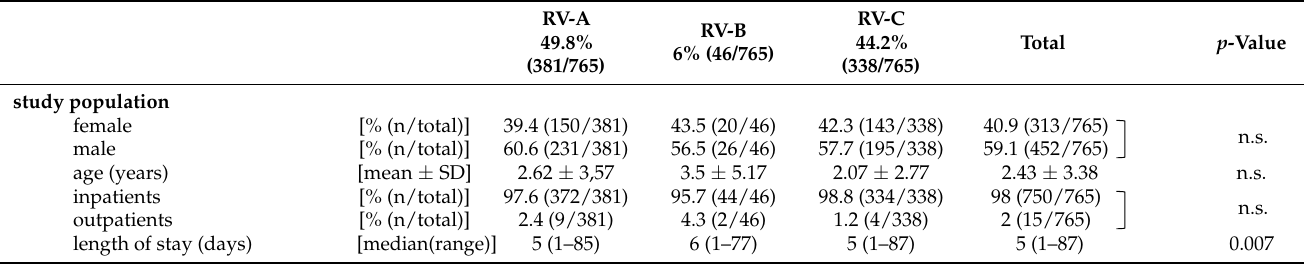
Table 2. Study population and clinical features of RV cases.